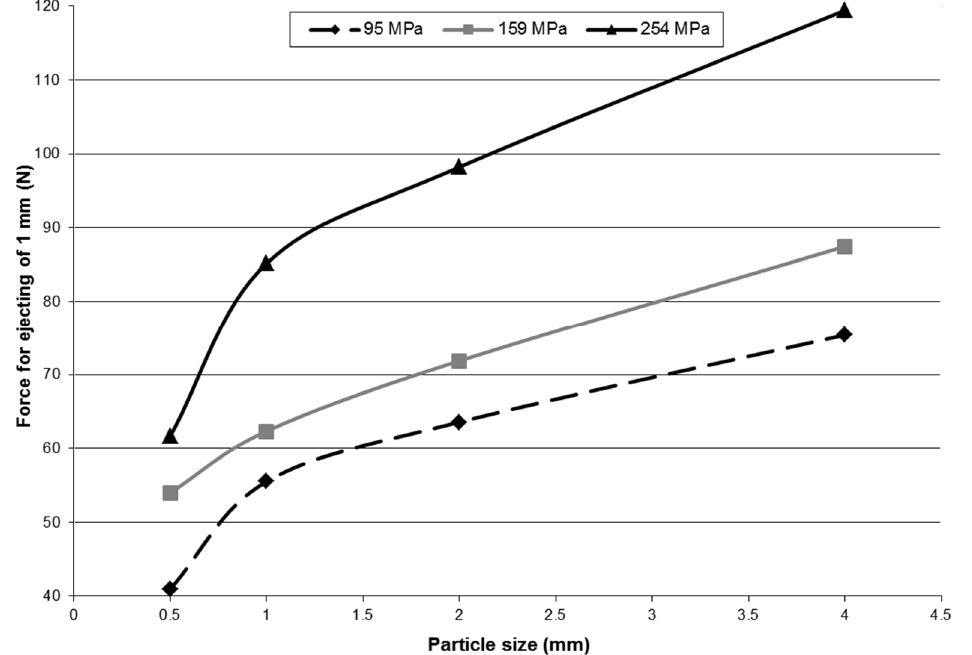
Figure 11. Interdependence of force needed to eject the briquette and particle size ( w r = 8%; T = 25